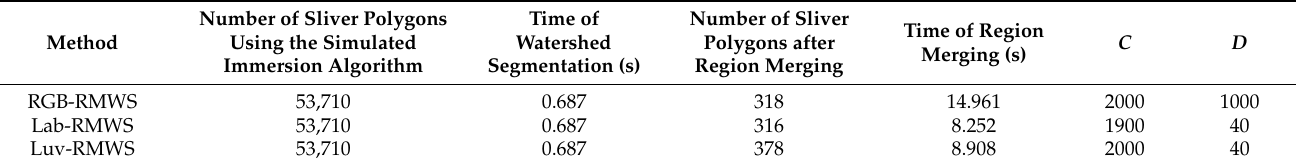
Table 7. Evaluation of the accuracies using the three methods.